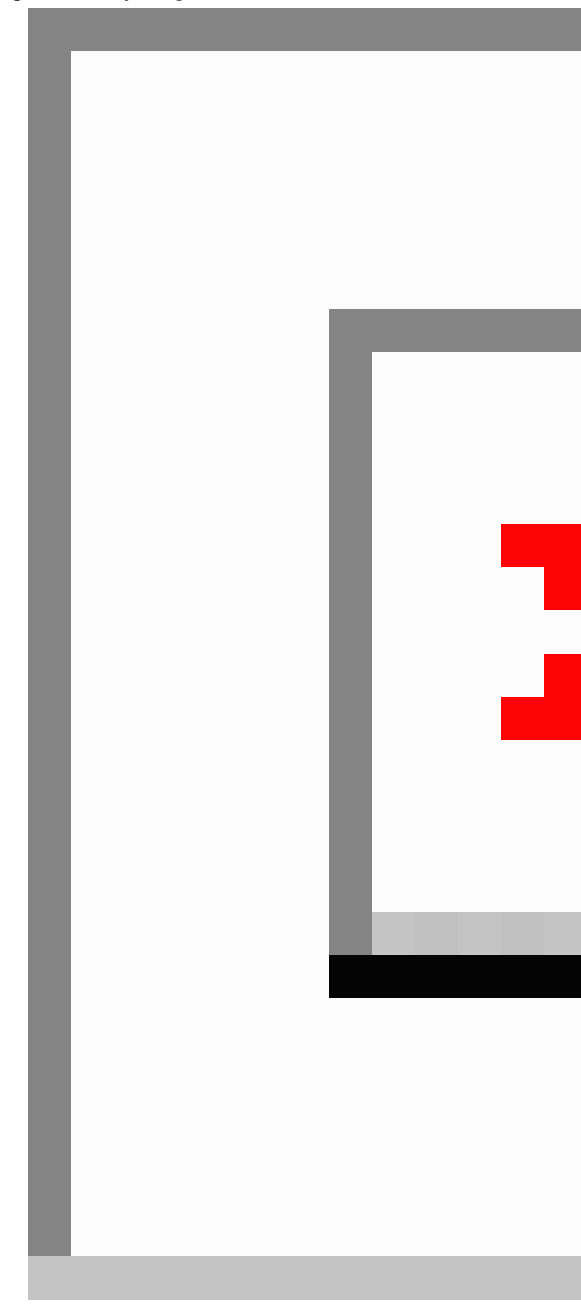
Figure 1. Study design